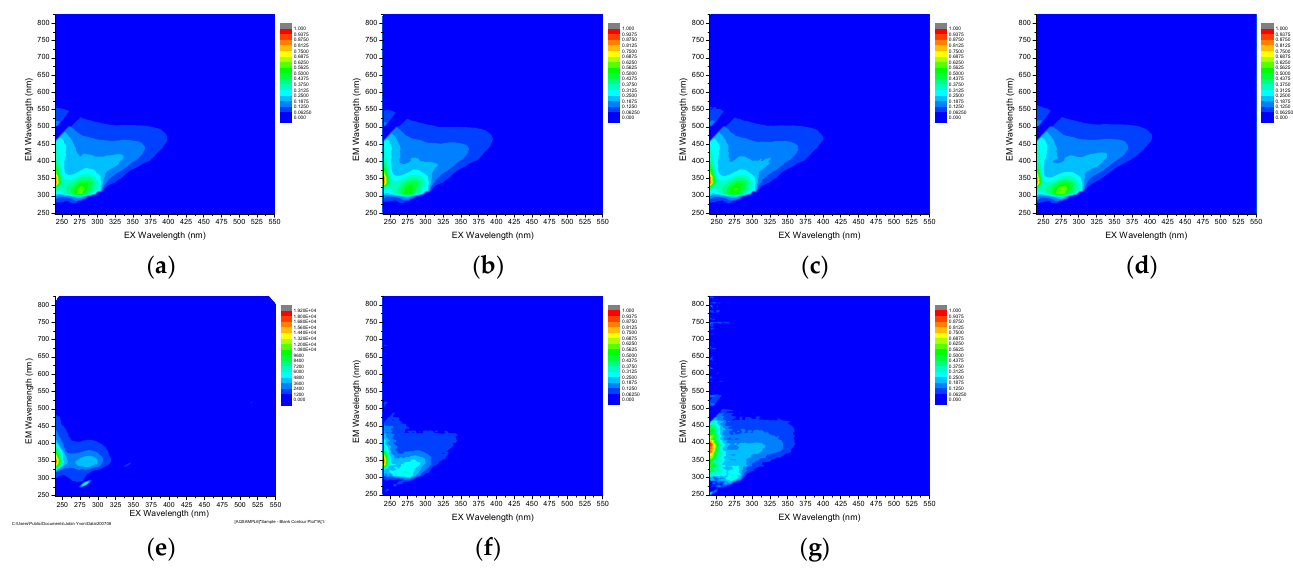
Figure 9. EEM data with different pretreatments: ( a ) WW: wastewater brine; ( b ) CF: cartridge filtration; ( c ) MF: microfiltration; ( d ) UF: ultrafiltration; ( e ) NF: nanofiltration; ( f ) AFM: activated filter media; and ( g ) GAC: granular activated carbon. Table 9. Fluorescing components determined by PARAFAC model [47–49].